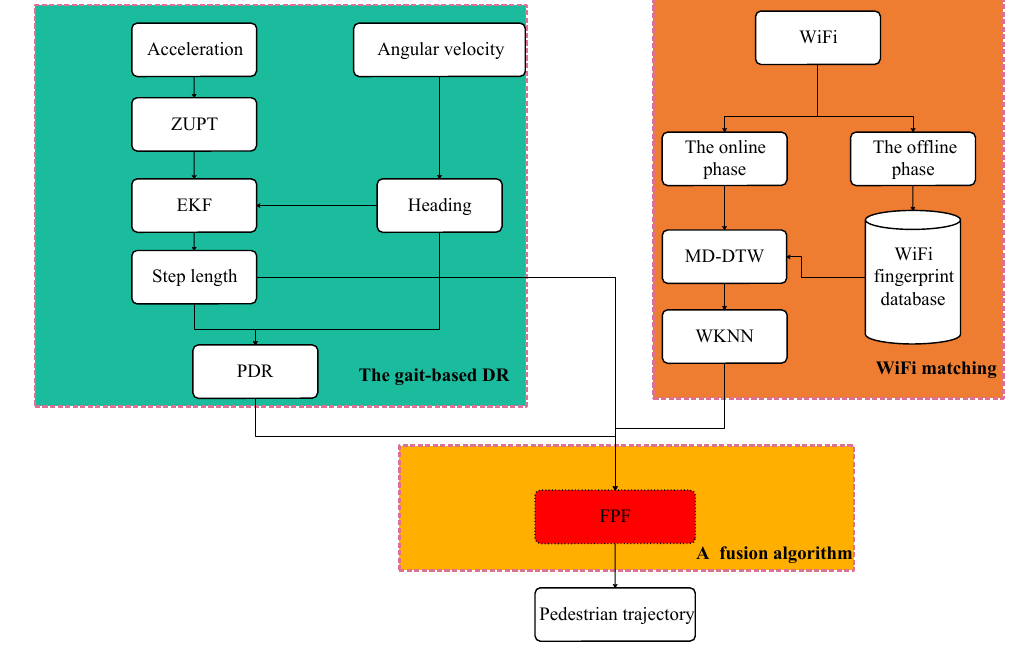
Figure 1. The structure of the indoor navigation